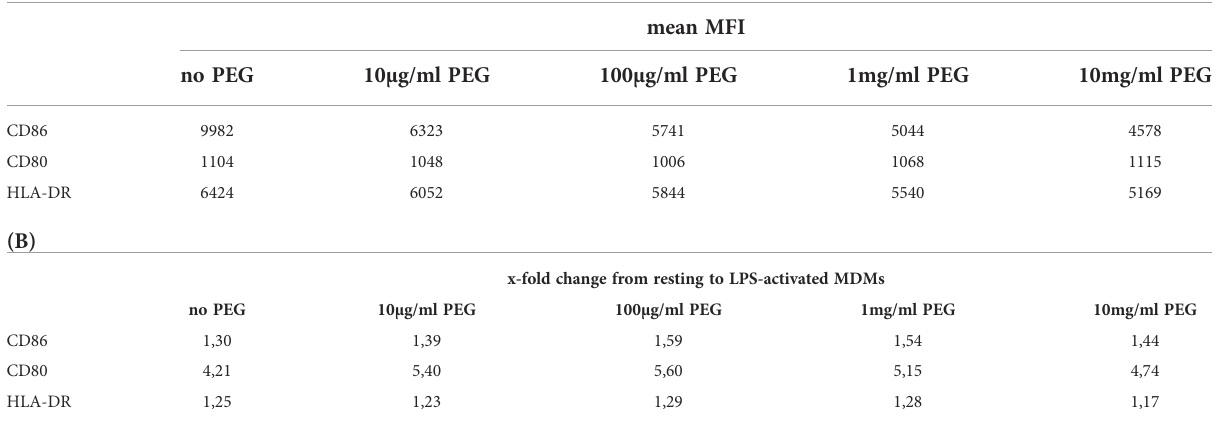
TABLE 1 Effect of PEG exposure on expression of human MDM surface